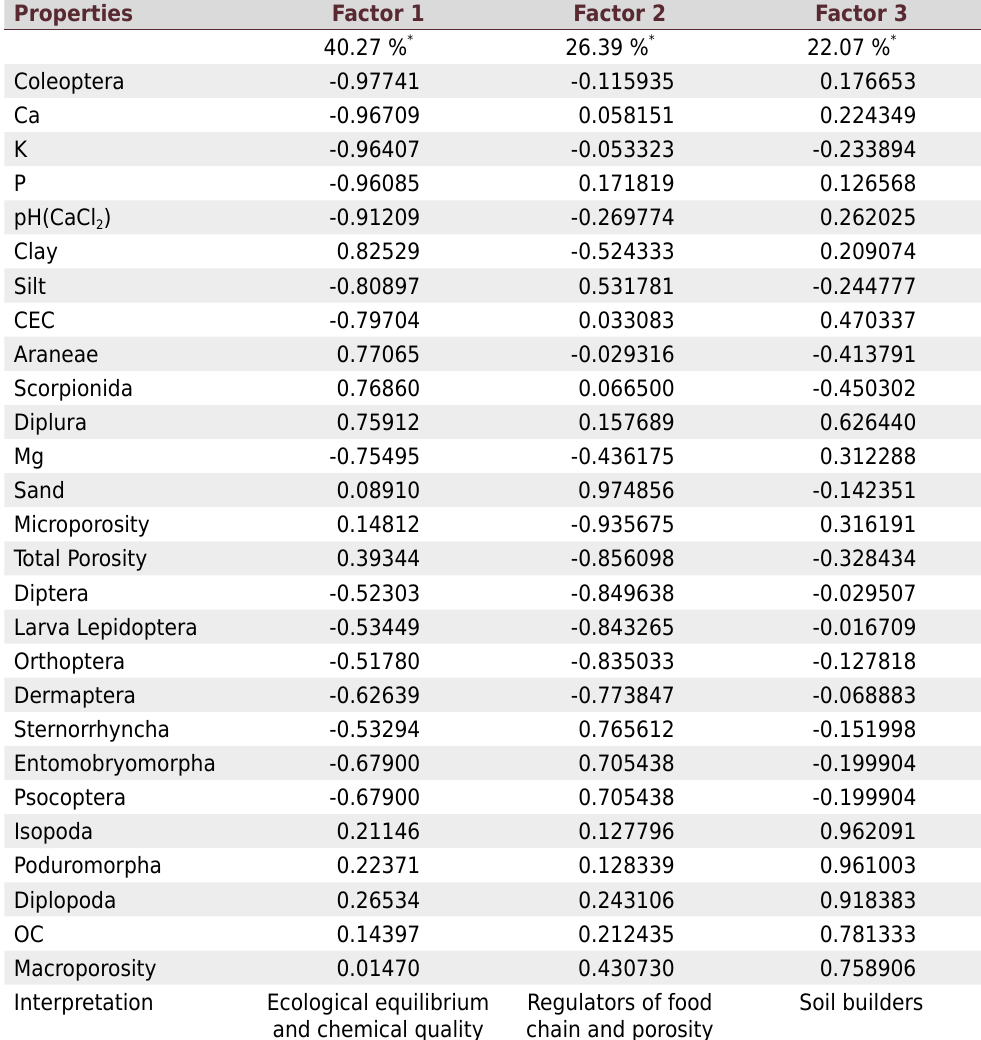
Table 3. Factor analysis with the first three factors and factorial charge that represent the correlation coefficients between soil properties and each factor